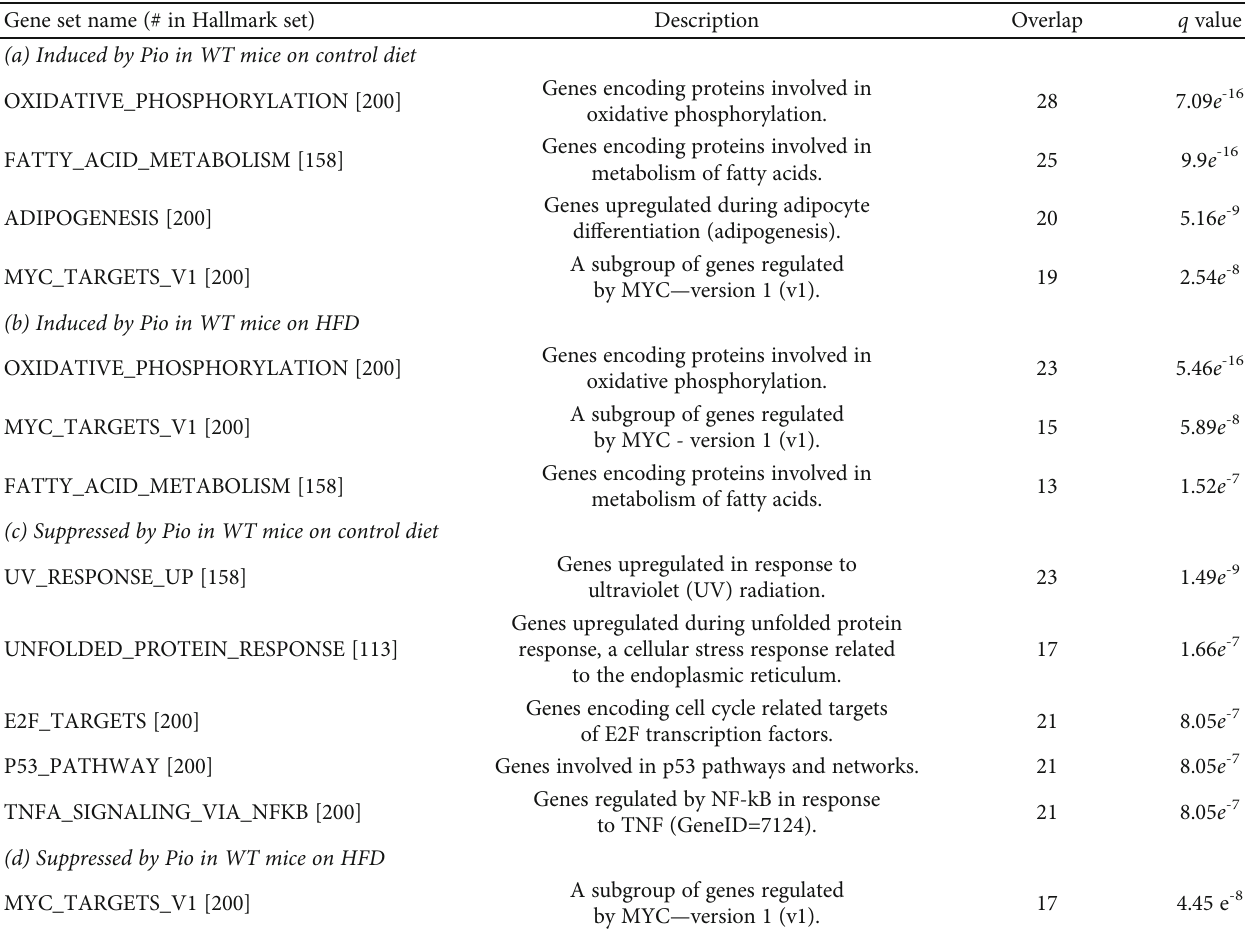
Table 4: Gene set analysis ∗ on BETA data from WT Pio-treated vs. Pio-untreated mice on control or HFD (as designated). Gene set name (# in Hallmark